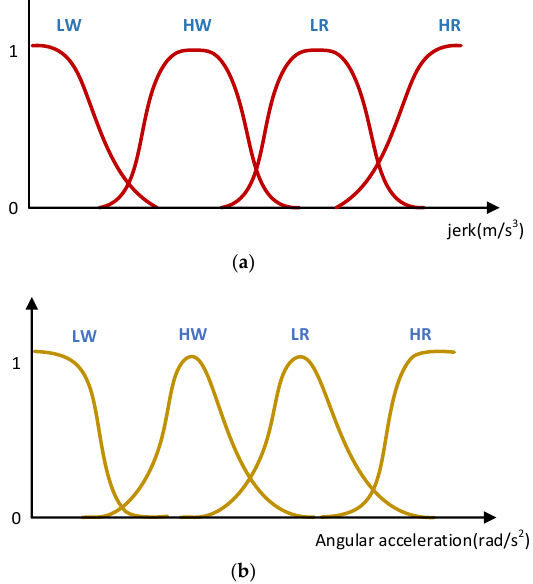
Figure 5. Two membership functions: ( a ) jerk membership function; ( b ) angular acceleration membership function.